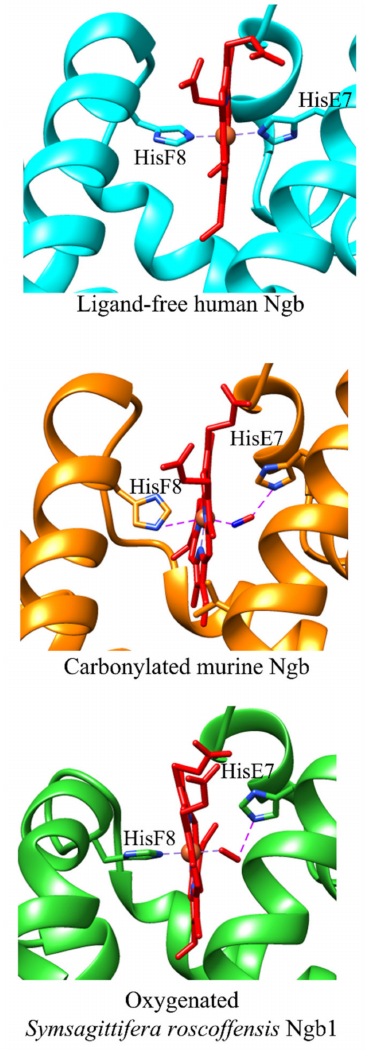
Figure 2. Heme cavities of six-coordinated ligand-free human Ngb (ID PDB code: 1OJ6) [32], carbonylated murine Ngb (ID PDB code: 1Q1F) [35], and oxygenated Symsagittifera roscoffensis Ngb1 (ID PDB code: 4B4Y) [50]. All pictures have been drawn by UCSF-Chimera package [84]. Values of k +1 for HisE7 binding to human Ngb(II) range from 2.0 × 10 3 s − 1 to 9.8 × 10 3 s − 1 (pH 7.0 and 20.0–25.0 ◦ C), and the value of k +1 for HisE7 binding to murine Ngb(II) is 2.0 × 10 3 s − 1 (pH 7.0 and 20.0 ◦ C) [85]. Values of k − 1 for HisE7 dis- sociation from human Ngb(II) range between 1.0 × 10 − 1 s − 1 and 8.2 × 10 3 s − 1 (pH 7.0 and 20.0–25.0 ◦ C), and k − 1 values of murine Ngb(II) range between 1.5 × 10 − 1 s − 1 and 1.2 s − 1 (pH 7.0 and 20.0–25.0 ◦ C) [16,44,78–80,85–91]. In the case of Ngb(III) the value